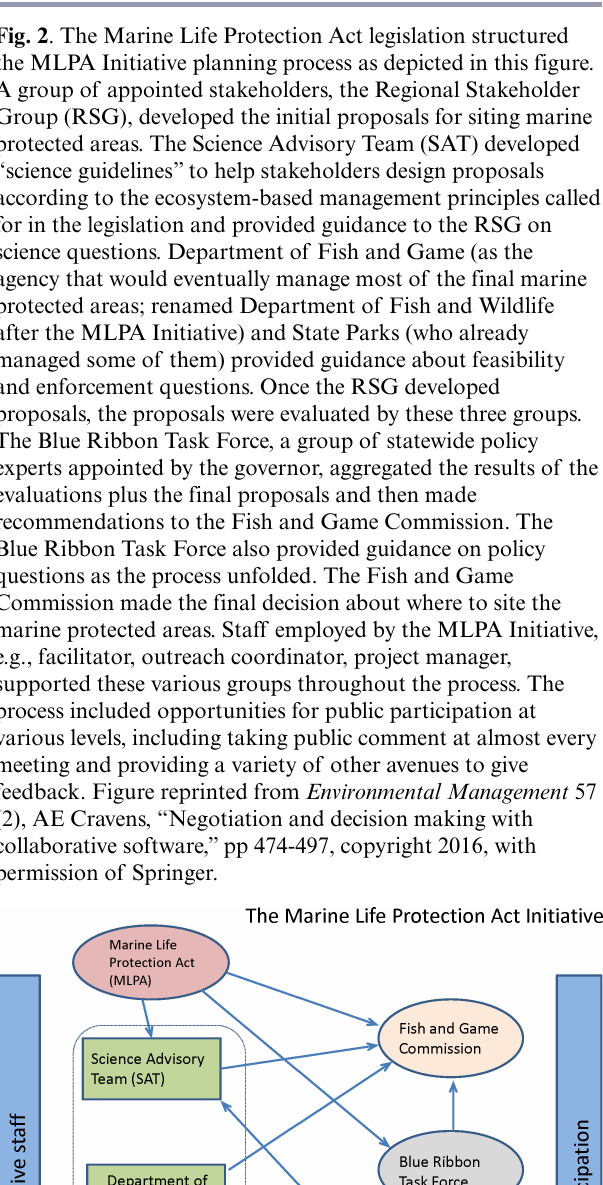
Fig. 2 . The Marine Life Protection Act legislation